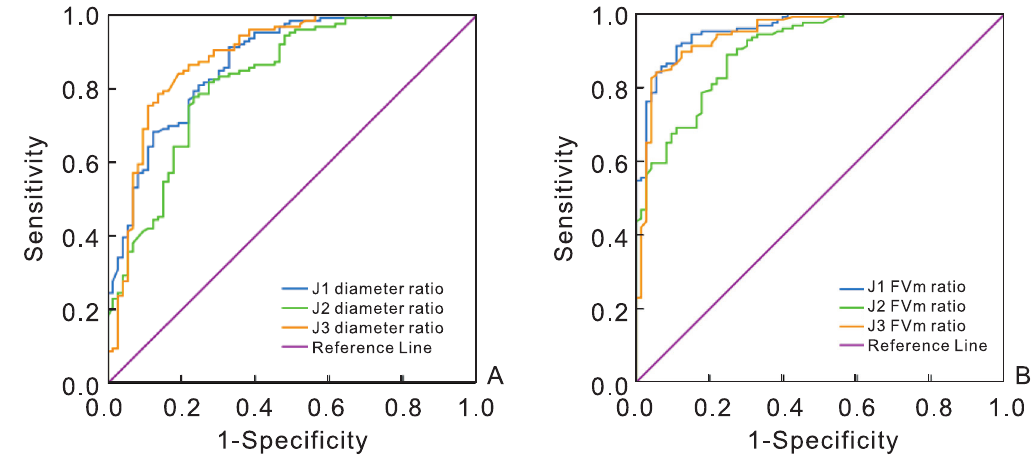
Figure 3 The ROC curves of J1 、 J2 、 J3 diameter ratio (A) and FVm ratio ( B ) for identifying IJV